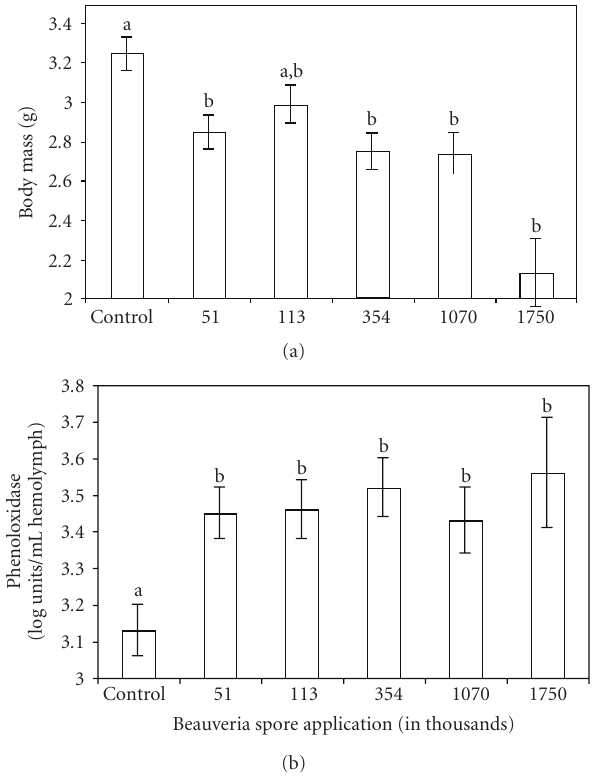
Figure 2: (a) Body mass and (b) phenoloxidase (PO) activity of adult Mormon crickets relative to the dose of Beauveria bassiana applied. Means and standard errors of the two replicates are shown with significantly di ff erent means in post hoc comparisons indicated by di ff erent